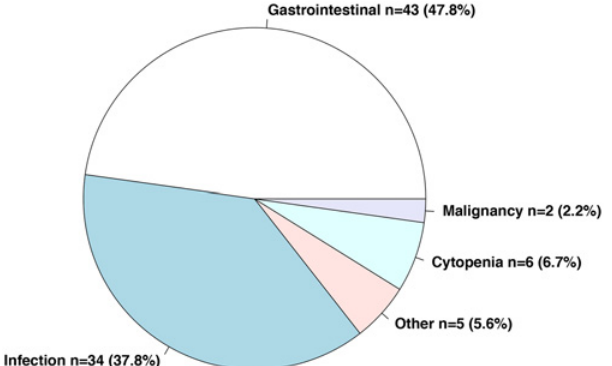
Fig 2. Circle chart of non-lethal adverse events in SSc patients treated with mycophenolate.